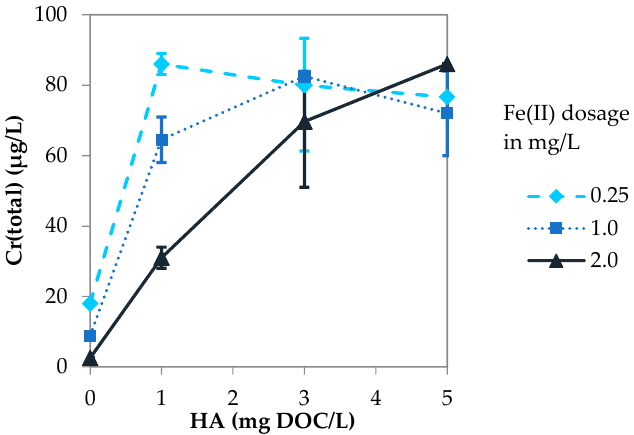
Figure 6. Cr(total) residual concentrations as a function of the presence of HAs (0, 1, 3, 5 mg DOC/L) at pH 7 and with Fe(II) dosages of 0.25, 1.0, and 2.0 mg /L. Mean values with vertical bars were used to indicate the range. The results were obtained with both set-ups A and B.